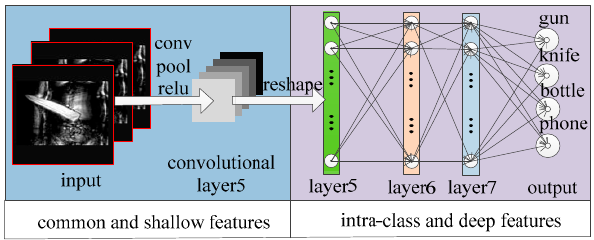
Figure 6. The interpretation of features extractions for different layers.